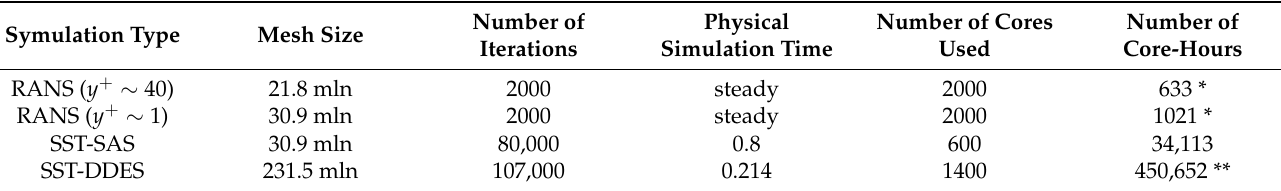
Table 4. Calculation cost for the simulations performed in this